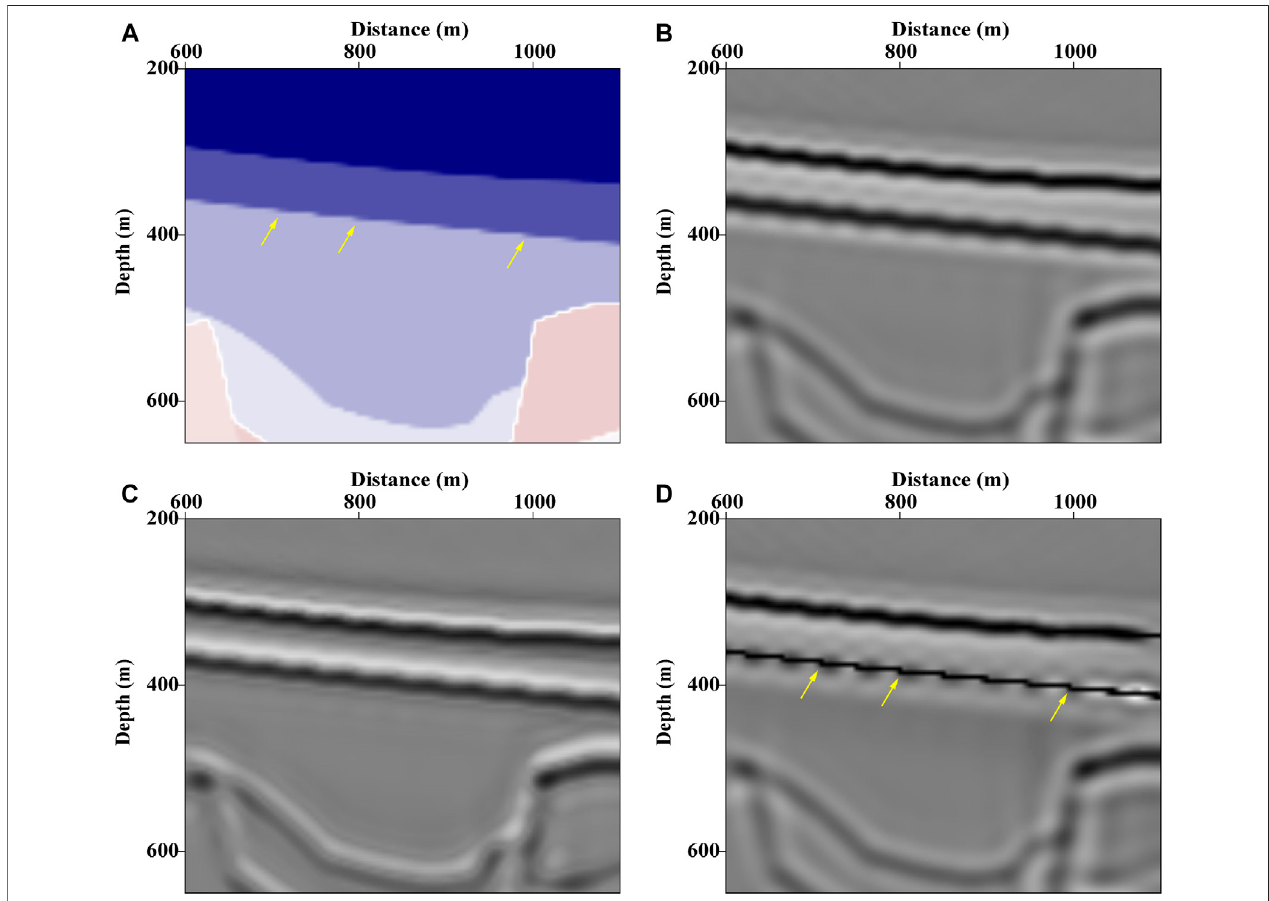
FIGURE 9 | The spectrum of inverted images form Figure 6